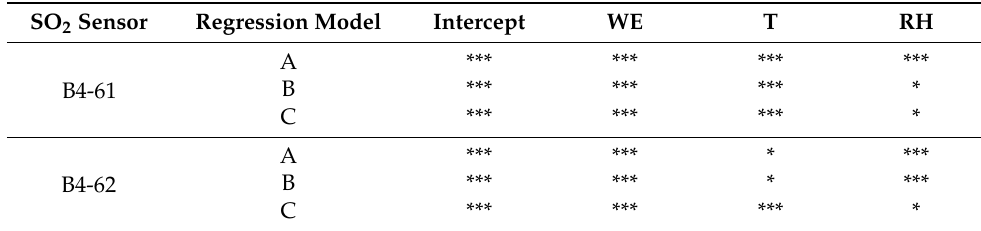
Table 6. Significance levels of the p -values for the variables used in the regression models for the SO 2 sensors (*** = 0.001, * =